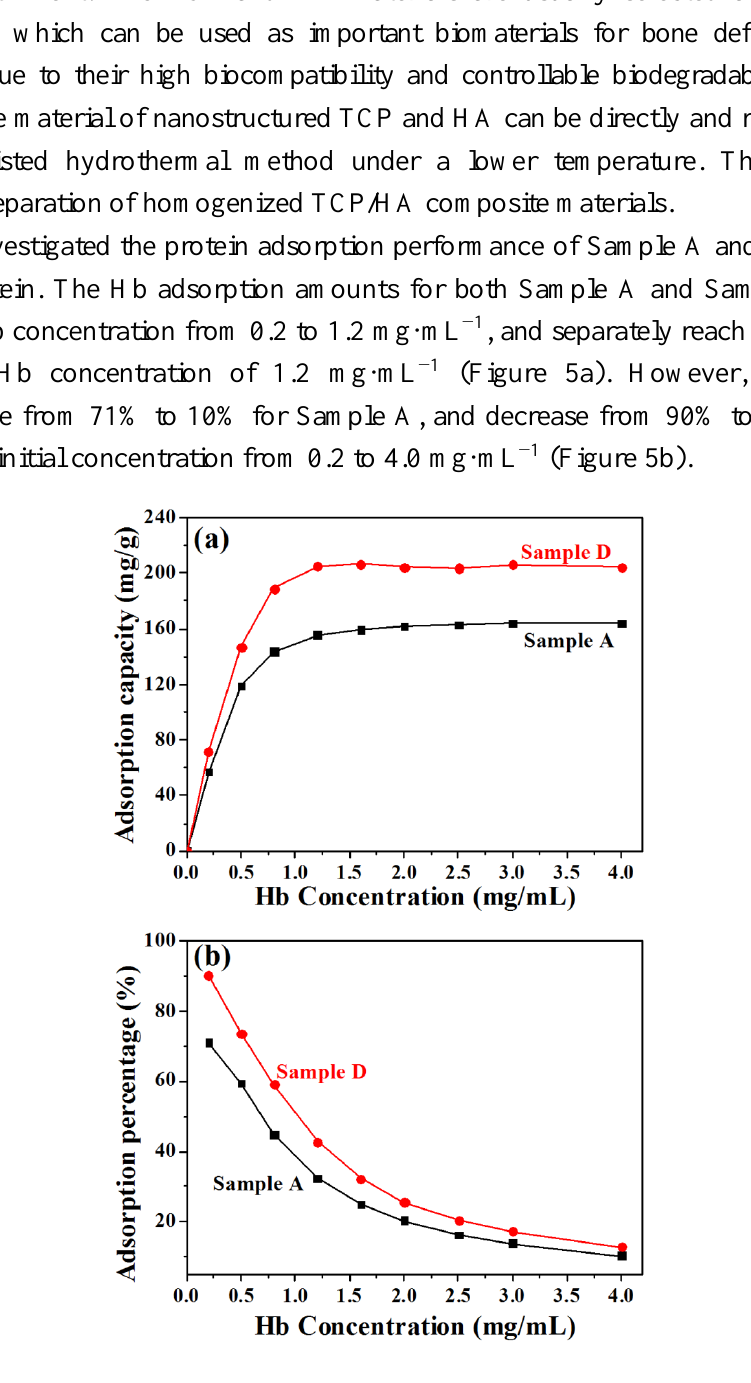
Figure 5. The Hb protein adsorption properties of Sample A (pH 5) and Sample D (pH 11). ( a ) Hb adsorption capacity as a function of initial Hb concentration; ( b ) Hb adsorption percentage as a function of initial Hb